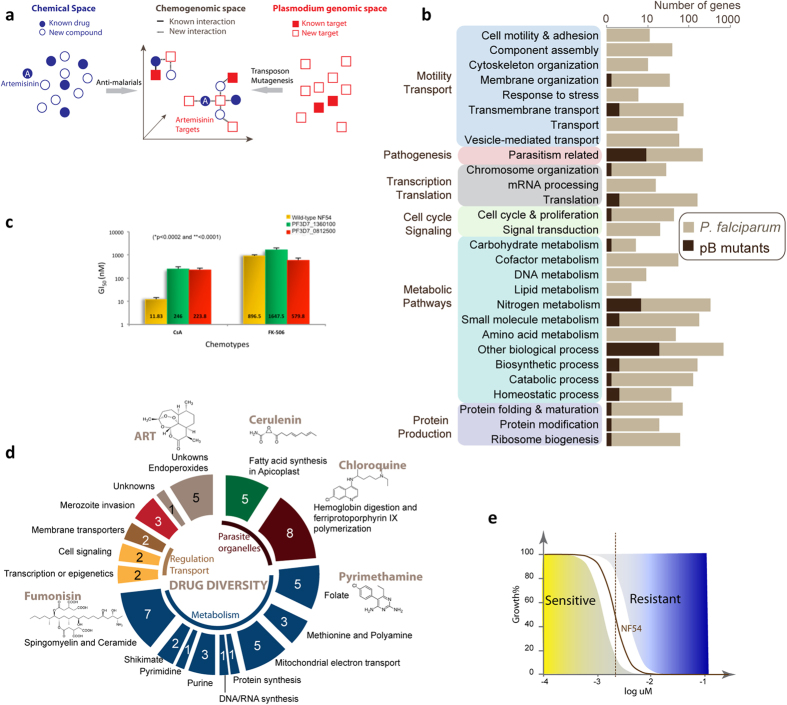
Chemogenomic profiling of piggyBac mutant clones of P. falciparum.(a) Hypothetical chemical-genomic interactions (redrawn from6). Similar mechanisms of action of unknown compounds can be defined in chemogenomic analysis by pair-wise comparison of responses with known drugs across mutants. (b) Overview of piggyBac insertions in the P. falciparum genome. The piggyBac mutants used in this study included insertions in genes of diverse GO categories and many essential biochemical pathways. The dark brown bars represent the proportion of genes of piggyBac insertions in each GO category (Generic GoSlim) with respect to the entire proteome of P. falciparum. (c) Growth inhibitory effect of CsA, an inhibitor of cyclophilin and FK-506, an inhibitor of FKBP on piggyBac mutants in which genes encoding two hypothetical RNA binding proteins that were predicted to interact with 6 different cyclophilins have been disrupted24. The resistance manifested in presence of CsA and FK-506 was statistically calculated significant (* = P < 0.0002 and ** < 0.0001). (d) Diversity of inhibitors and antimalarial drugs used in screen. Representative drugs are shown for some categories. The mechanism of actions have been derived from science literature search and compilation, as listed in Supplemental Table S2 (the drug mechanism table). (e) hypothetical dose response data for piggyBac mutants with varying degrees of susceptibility. A dashed line crosses the hypothetical drug response curve at the IC50 indicates the 50% growth inhibitory concentration of drug in an assay. The clear area along the drug response curve indicates variations that do not reflect a significant change from the dose response of NF54. A shift to the right would reflect an increased drug concentration necessary to achieve the same effective inhibitory concentration as NF54, or increased resistance for a piggyBac mutant. A shift to the left would reflect a decreased drug concentration necessary to achieve the same effective inhibitory concentration as NF54, or increased sensitivity for a piggyBac mutant. The blue-yellow color scheme is used in Figure 2a to reflect relative to NF54 piggyBac mutant changes in resistance and sensitivity, respectively.